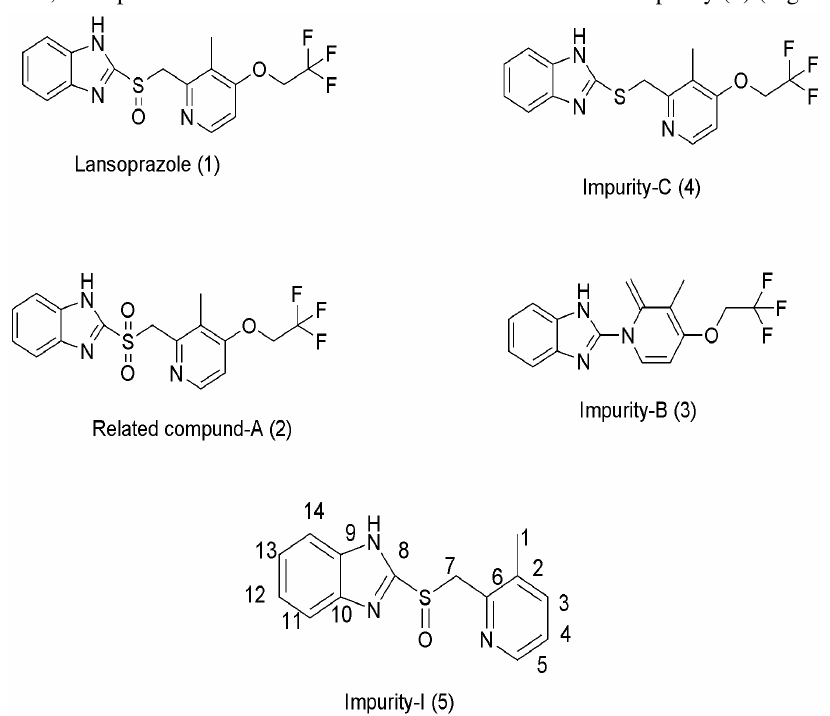
Figure 1. Structures of lansoprazole and